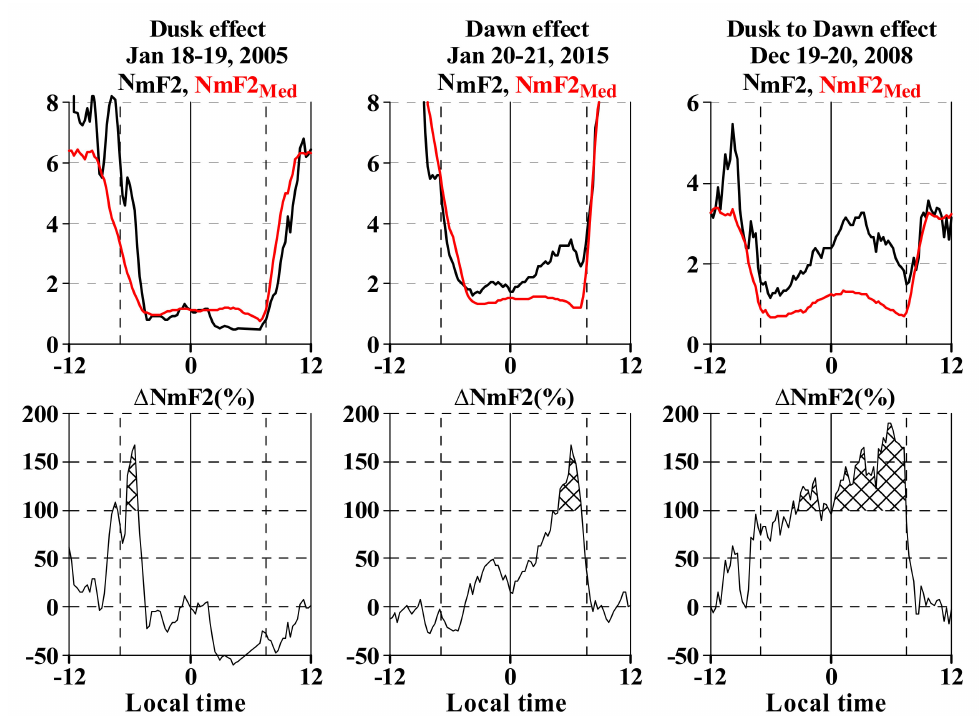
Figure 1. Upper panels show local time variations in observed NmF2 (black) and median NmF2 (red). Lower panels show local time variations in NmF2 disturbances ( ∆ NmF2) in %. The three columns correspond to three nights: 18–19 January 2005, 20–21 January 2015, and 19–20 December 2008 (from left to